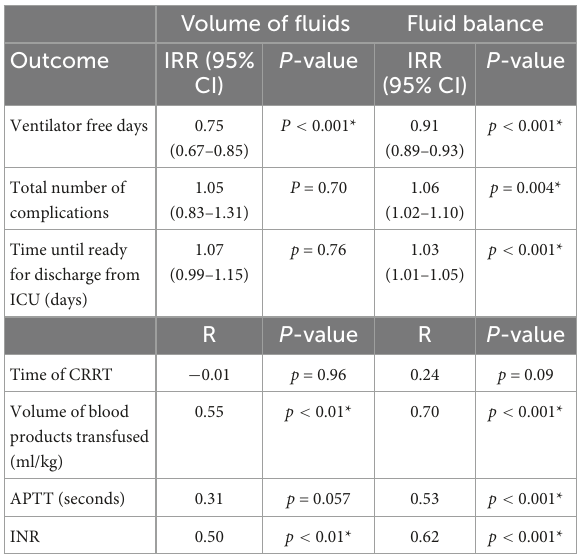
TABLE 3 Relationship between volume of fluids (ml/kg/h) or fluid balance (liters) and outcomes in critically ill trauma patients.